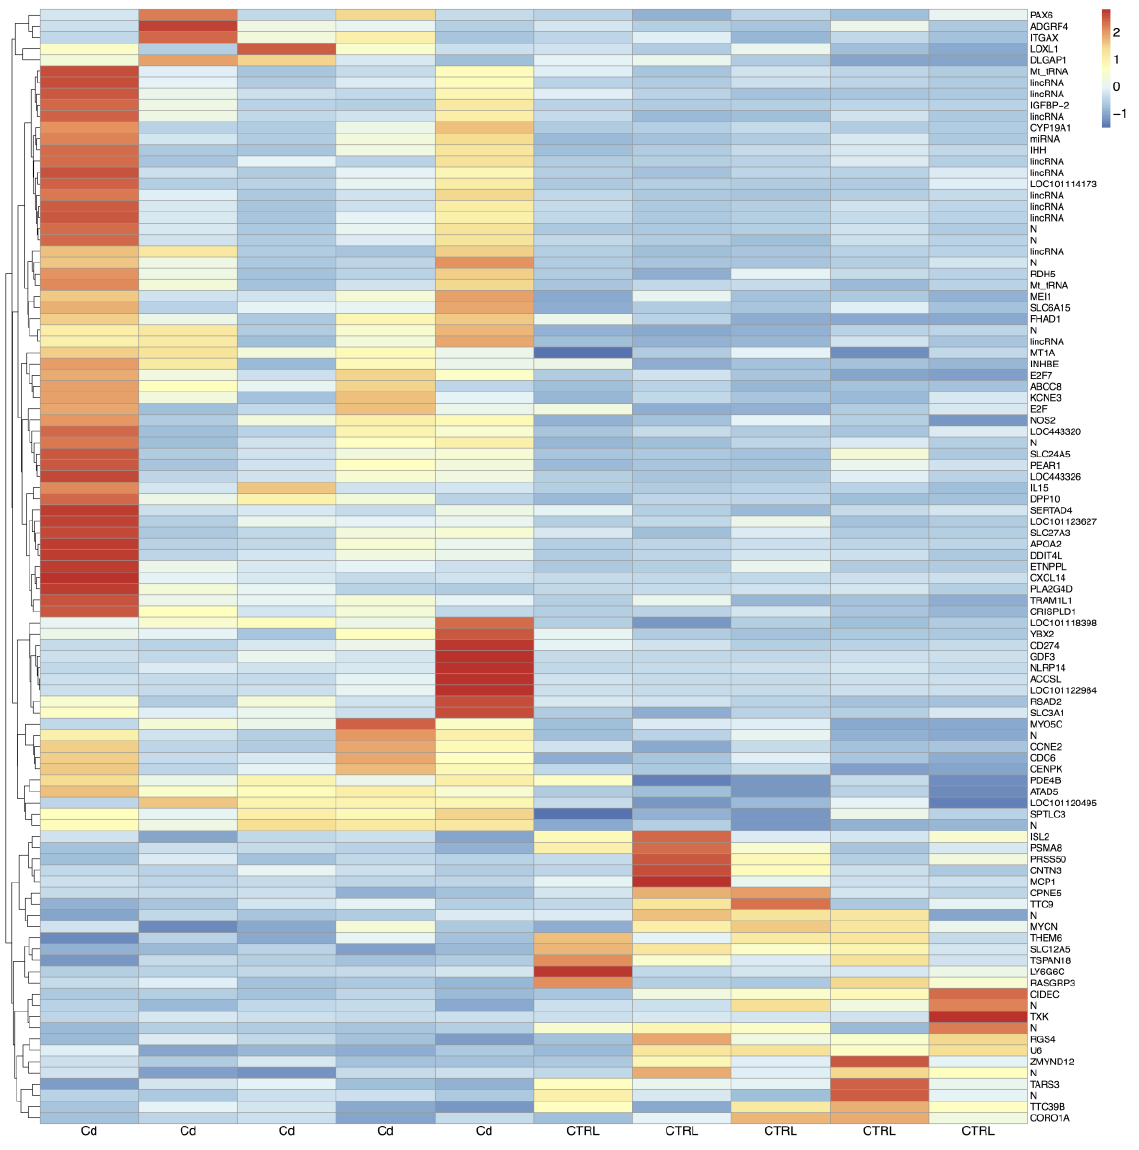
Figure 2. Heatmaps of DEGs in Cd-exposed versus control CCs from adult sheep. Blue to red colouration denotes low to high expression levels, respectively. Abbreviations: Cd, cadmium; CTRL, controls.